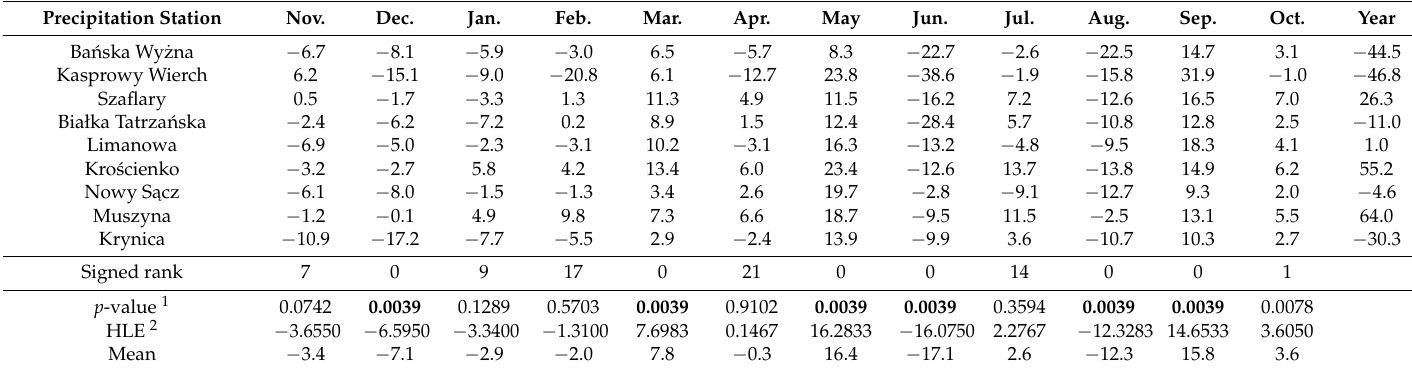
Table 3. Difference in monthly precipitation (mm) between the most recent 30-year period (1986–2015) and the previous 30-year period (1956–1985). According to the Wilcoxon signed rank test with the Bonferroni correction, the median of the difference in precipitation for each month is significant at p < 0.0042.